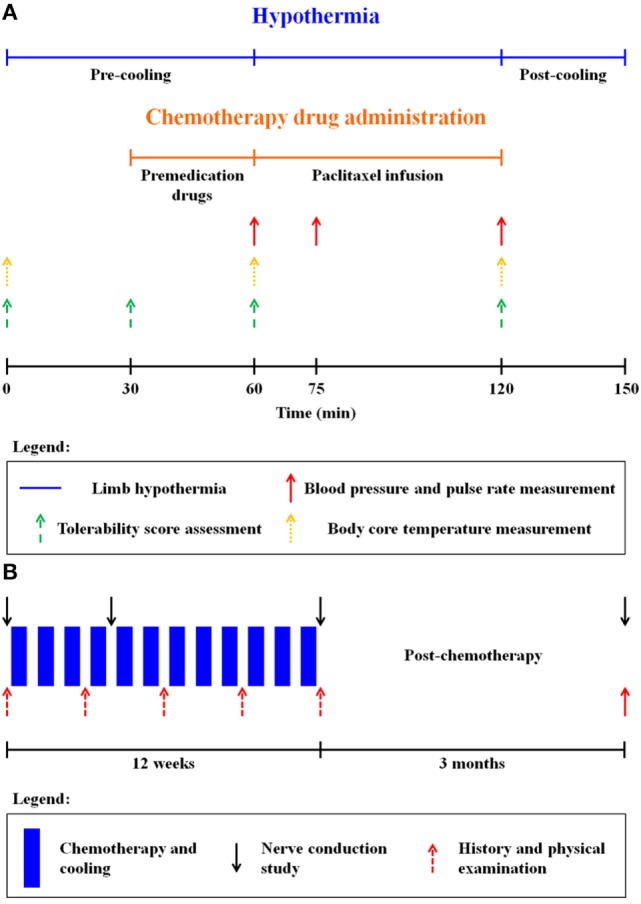
(A) Limb hypothermia protocol for one chemotherapy cycle. Premedication drugs: dexamethasone, diphenhydramine, and ranitidine. (B) Study schema.